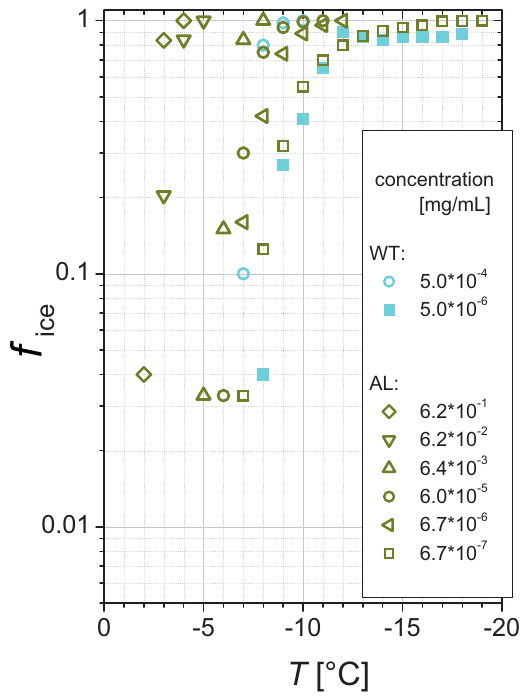
Figure 6. Frozen fractions as a function of temperature measured with AL and WT for differently concentrated Snomax suspensions. Data for the one data set which showed a plateau value below 1 are displayed with closed symbols. When the same symbols were used, the mass of Snomax per droplet was